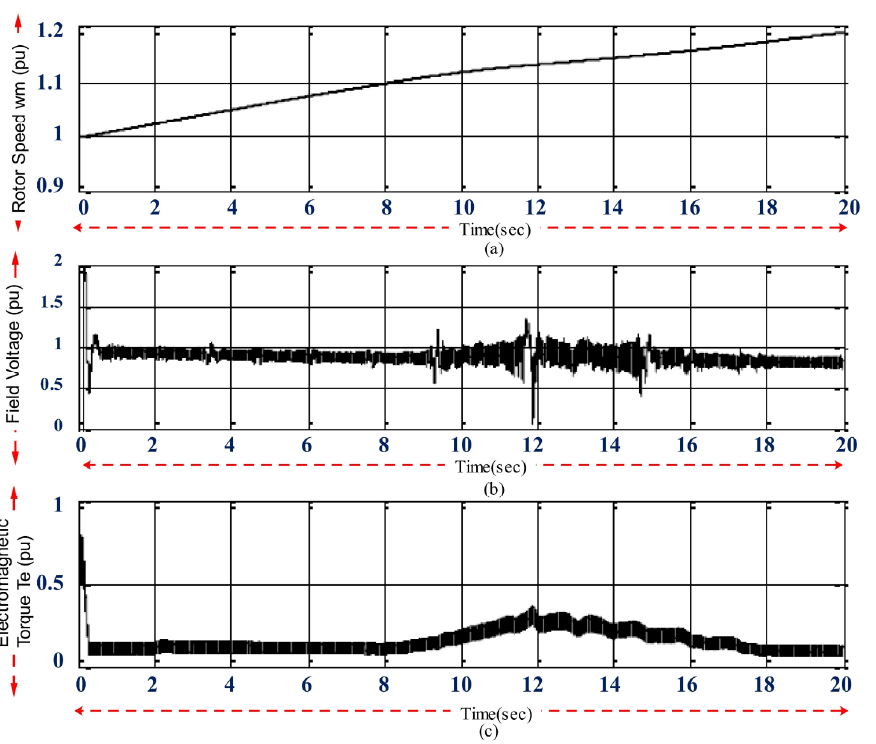
Figure 18. Diesel generator operation in a microgrid separated from the distribution network (off- grid); ( a ) angular speed; ( b ) stimulation voltage; ( c ) DC electromechanical torque .